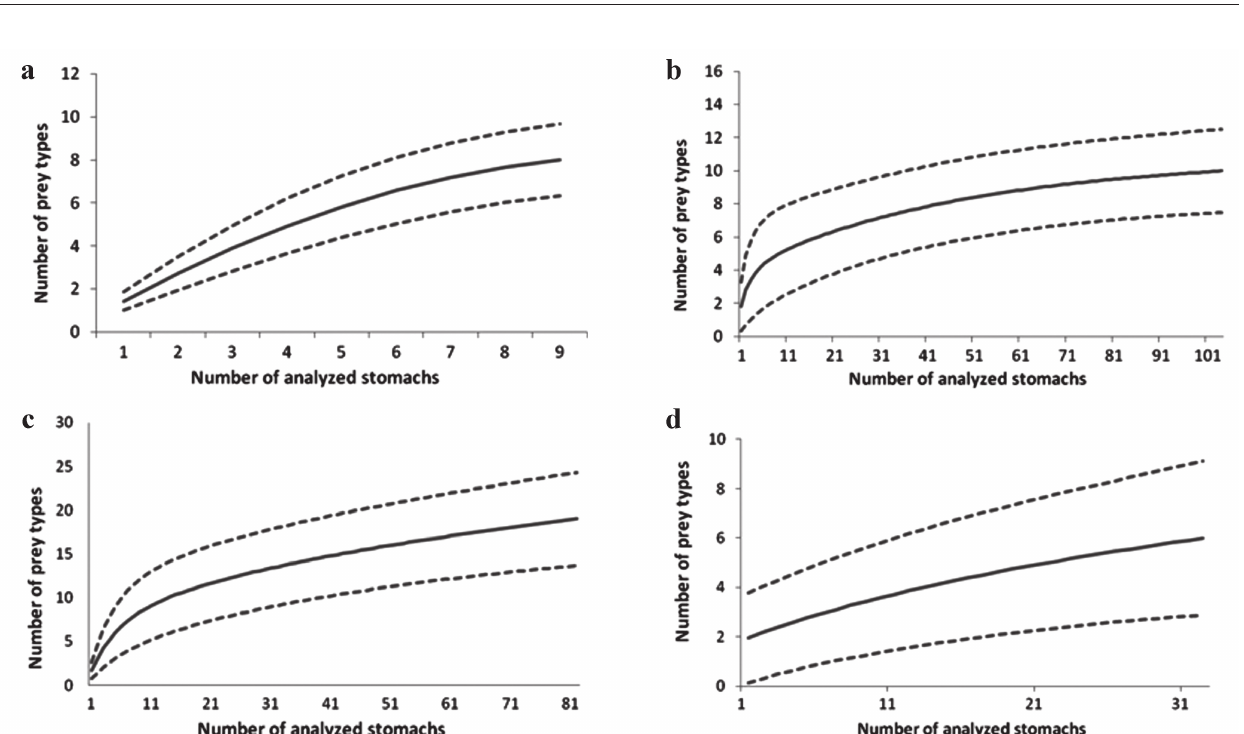
Fig. 2. Cumulative prey curve for the diet of ( a ) Psammobatis rutrum ; ( b ) Psammobatis extenta ; ( c ) Rioraja agassizii ; ( d ) Rhizoprionodon lalandii ± Confidence Intervals (p=0.05) in the southeastern Brazil, between January 2006 and August